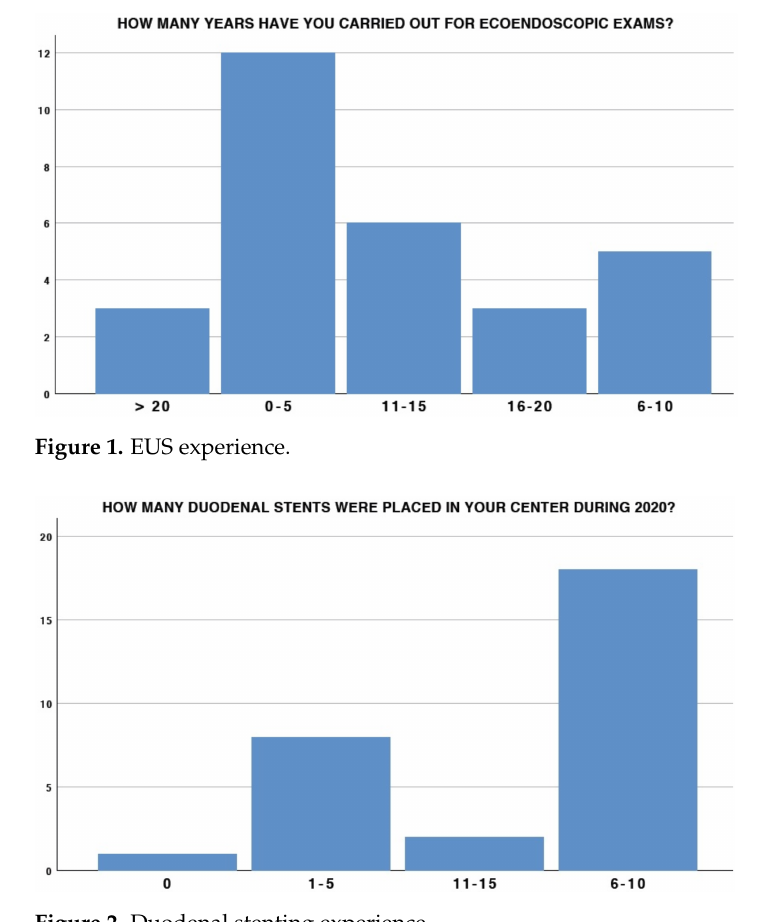
Figure 2. Duodenal stenting experience.